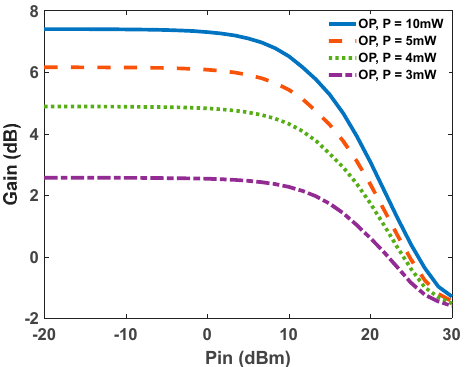
Figure 11. Gain versus input power for 4 distinct pump powers.